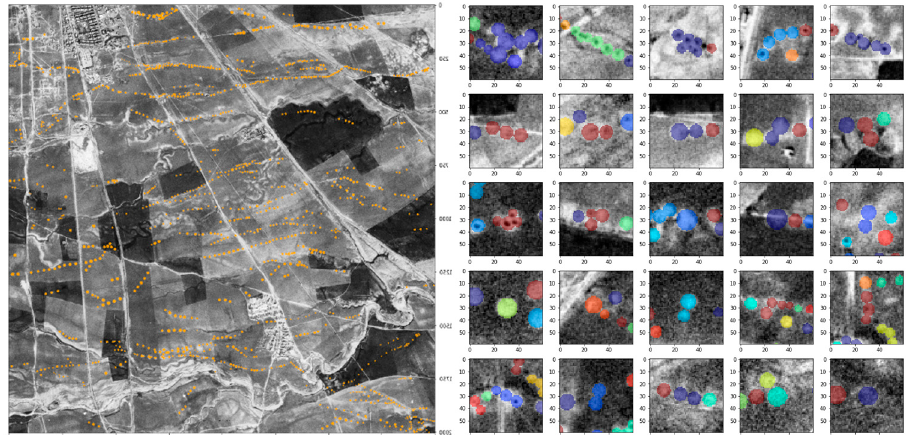
Figure 7. During data pre-processing, we conducted exploratory data analysis (EDA) to verify that connected components (individual segments) are of reasonable size. Random distinguishing colors were assigned to annotated cases so that outliers and connected components (in the cases where shaft labels overlapped) can be quickly identified. We used this size insight in the post-processing phase to remove some noise. (Note that the left image is flipped vertically in the course of the data augmentation process).